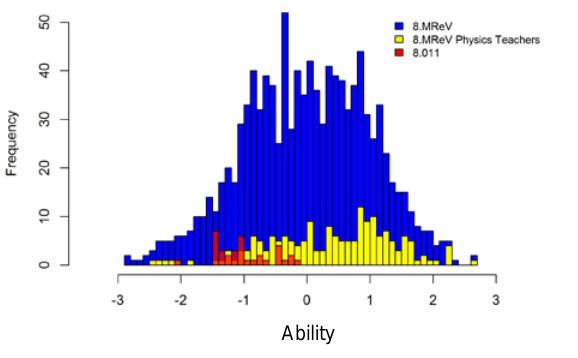
Figure 5. The distribution of abilities in 8.MReV overall, the teacher cohort in 8.MReV (yellow), and the on-campus 8.011 students